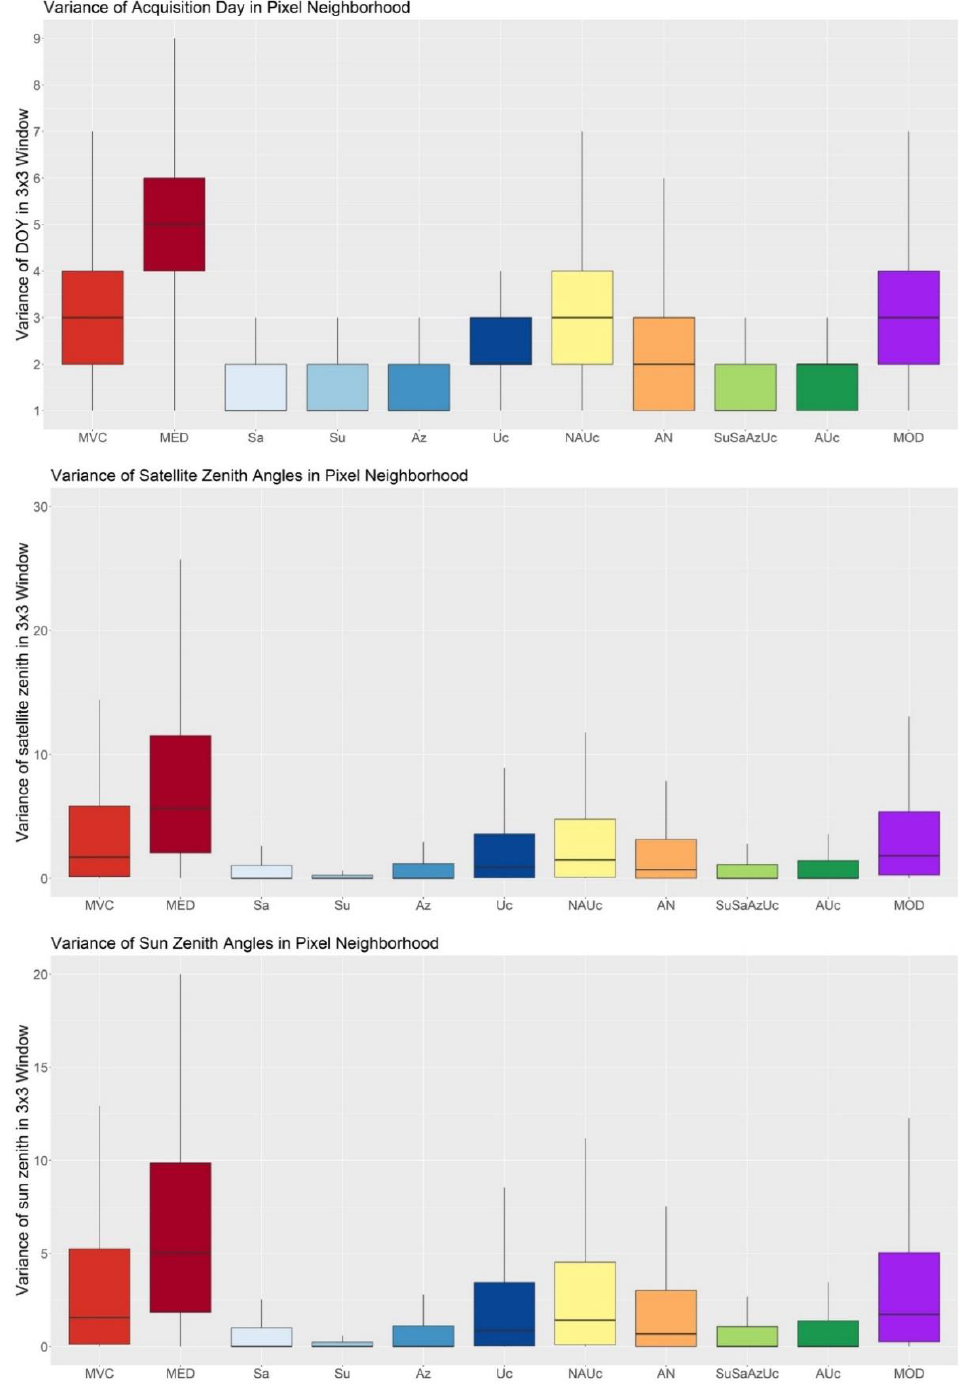
Figure 10. Neighborhood homogeneity characterized by DOY ( top ), satellite zenith ( middle ), and sun zenith variance ( bottom ) in 3 × 3 window of all monthly composites for all